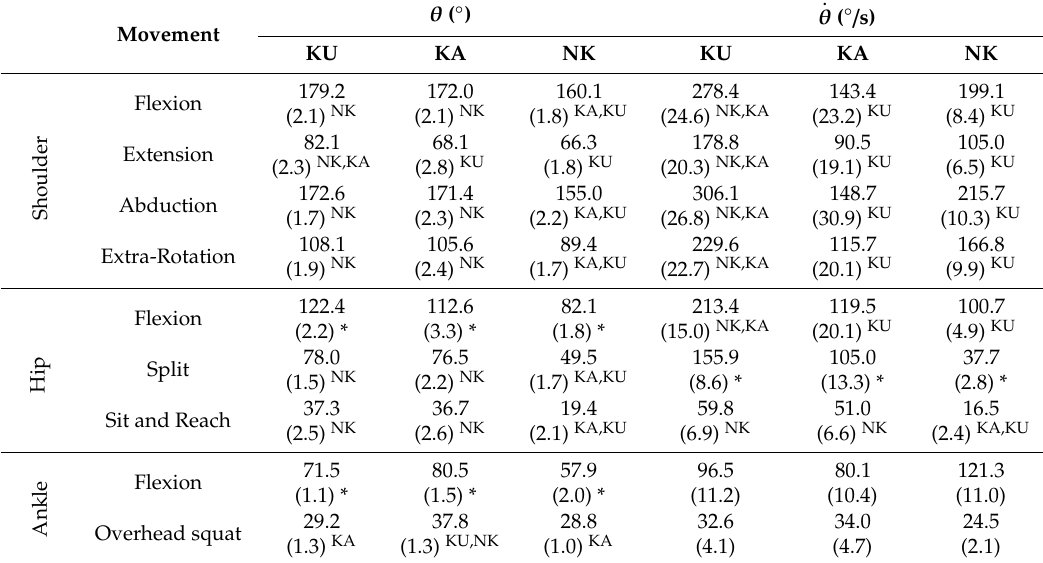
. θ obtained during the joint mobility test performed Table 1. Mean values (standard errors) for θ and at the preferred velocity for all the examined groups. KU, KA, and NK stand for kumite, kata, and non-karatekas group, respectively. Superscripts represent statistical di ff erences, with * indicating di ff erence among all